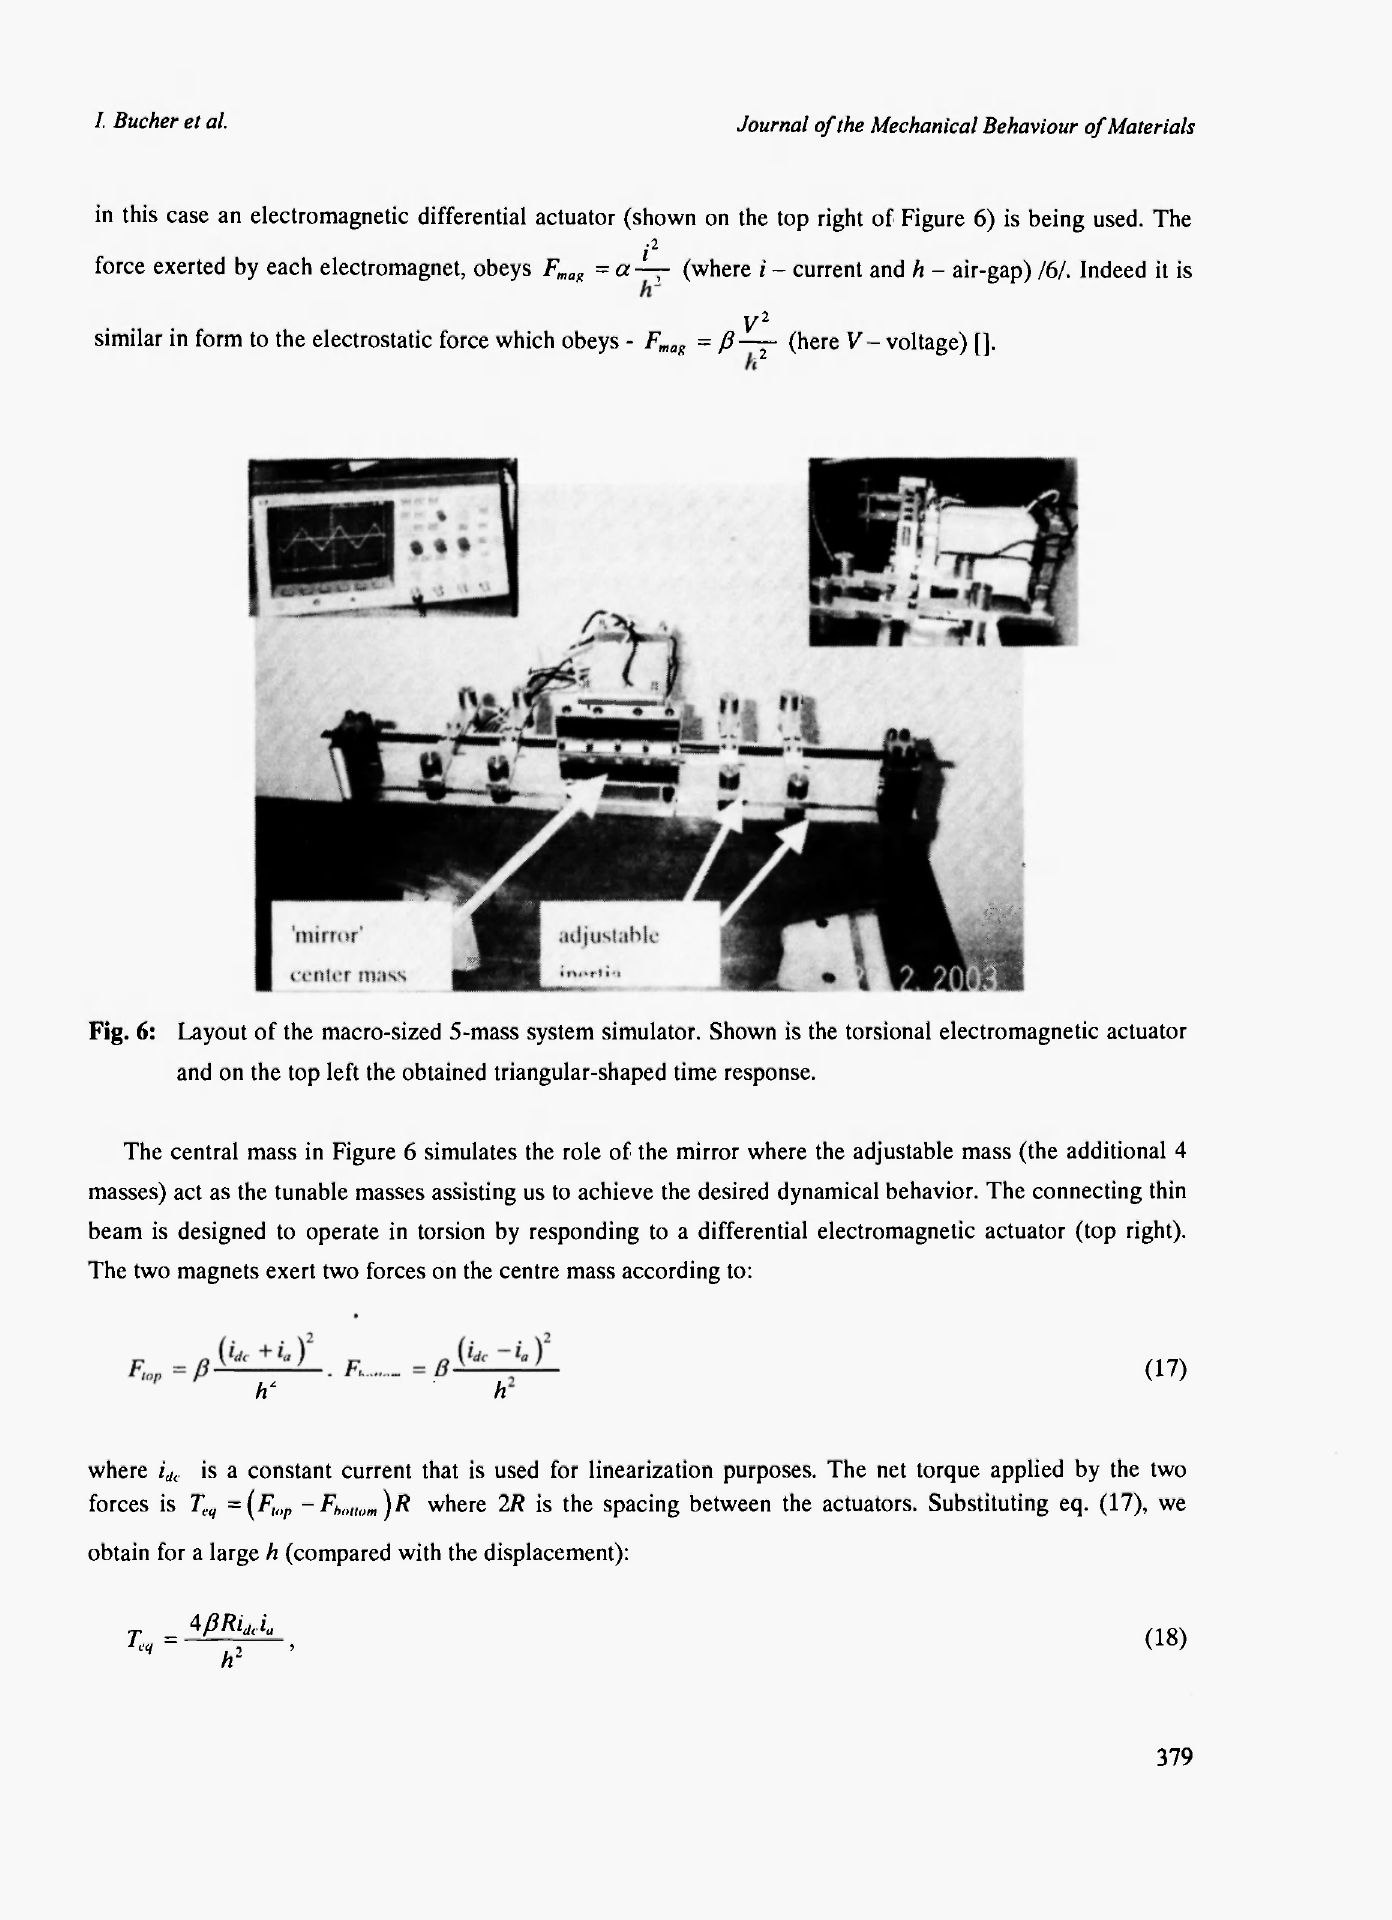
The central mass in Figure 6 simulates the role of the mirror where the adjustable mass (the additional 4 masses) act as the tunable masses assisting us to achieve the desired dynamical behavior. The connecting thin beam is designed to operate in torsion by responding to a differential electromagnetic actuator (top